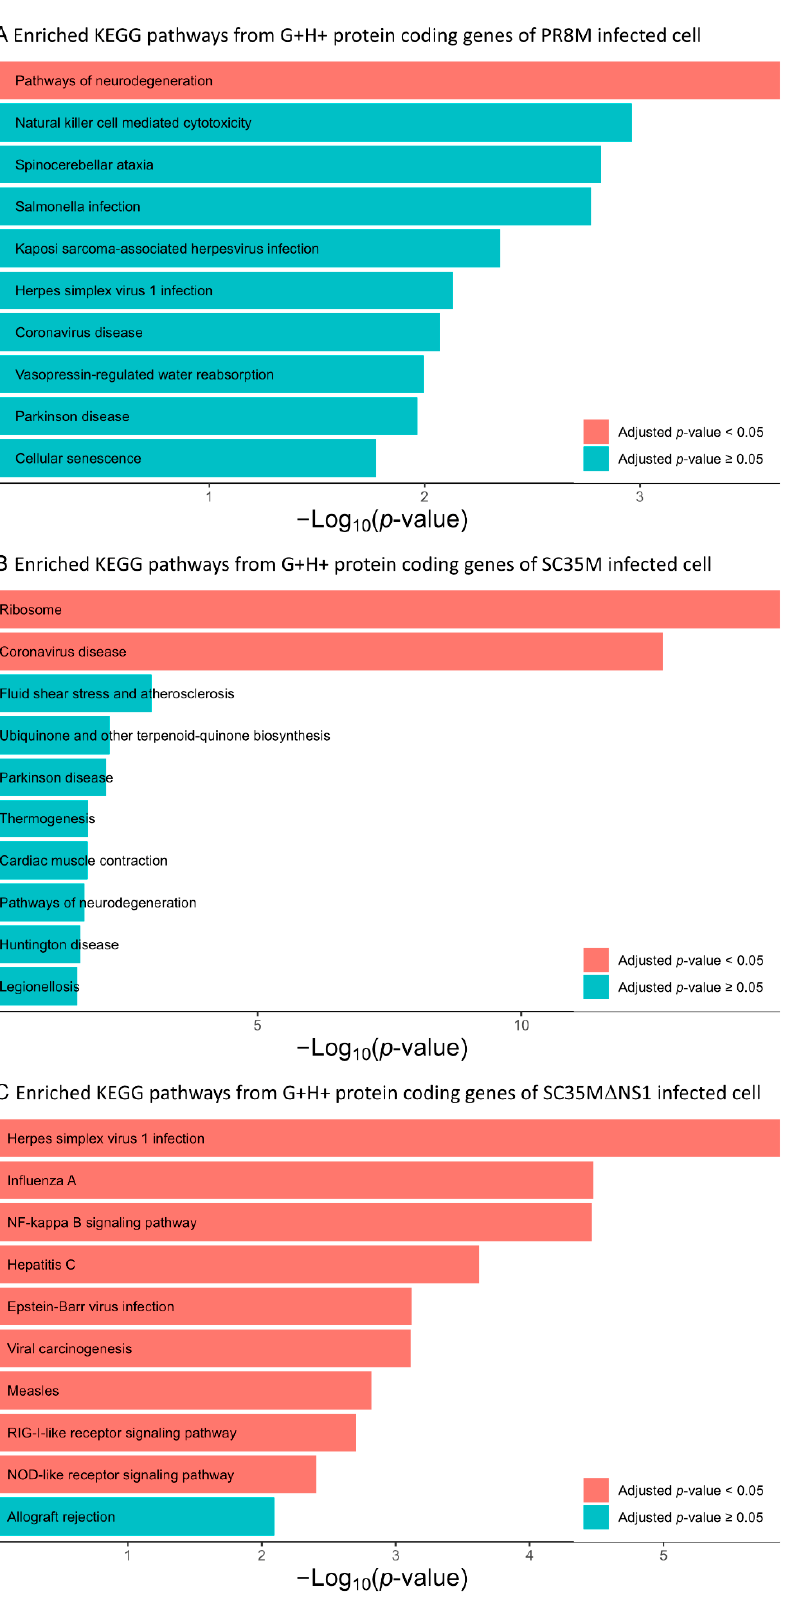
Figure 6. Top 10 most significantly enriched KEGG pathways associated with the protein-coding genes of the G+H+ DEHERV-G pairs. Terms are ranked according to the p -value and bars filled in blue means their p -value lower than 0.05 while Benjamini–Hochberg corrected p -values larger than 0.05. ( A ) PR8M infected cells, ( B ) SC35M infected cells, ( C ) SC35M Δ NS1 infected cells.